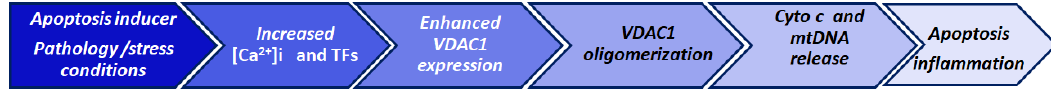
Figure 2. Sequence of events leading to VDAC1 overexpression, oligomerization, and apoptosis. Apoptosis stimuli or pathological conditions enhance VDAC1 expression via Ca 2+ or transcription factors (TFs) activating promoter, leading to VDAC1 transcription.